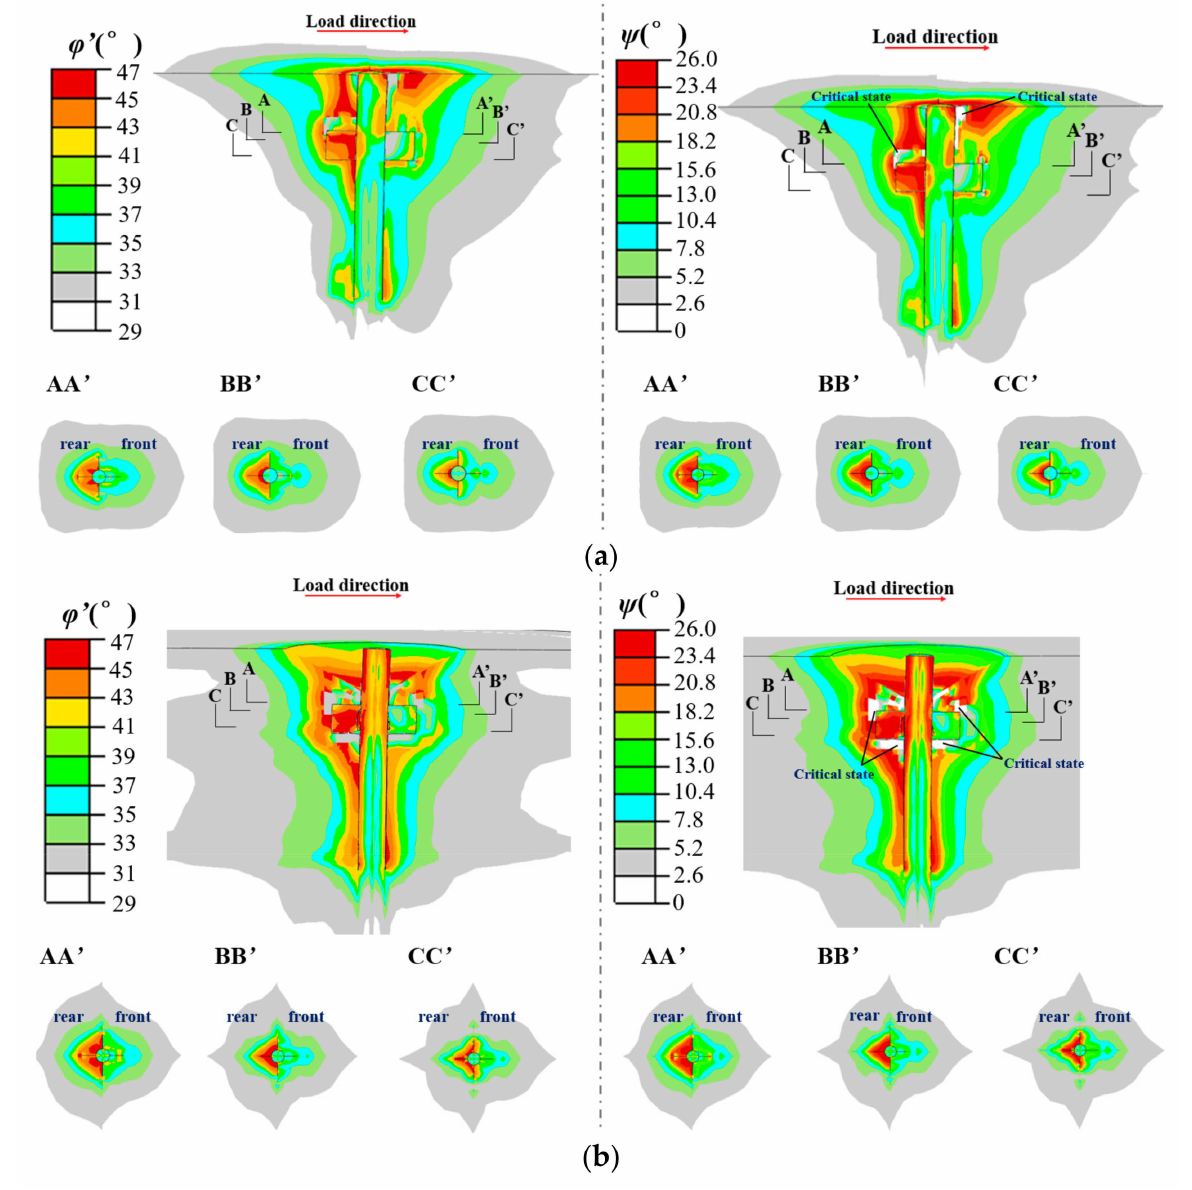
Figure 11. Modified friction angle ϕ (cid:48) and dilation angle ψ of the sand in the plane of symmetry at θ = 2 ◦ : ( a ) without local scour; ( b ) with local scour ( S/D =